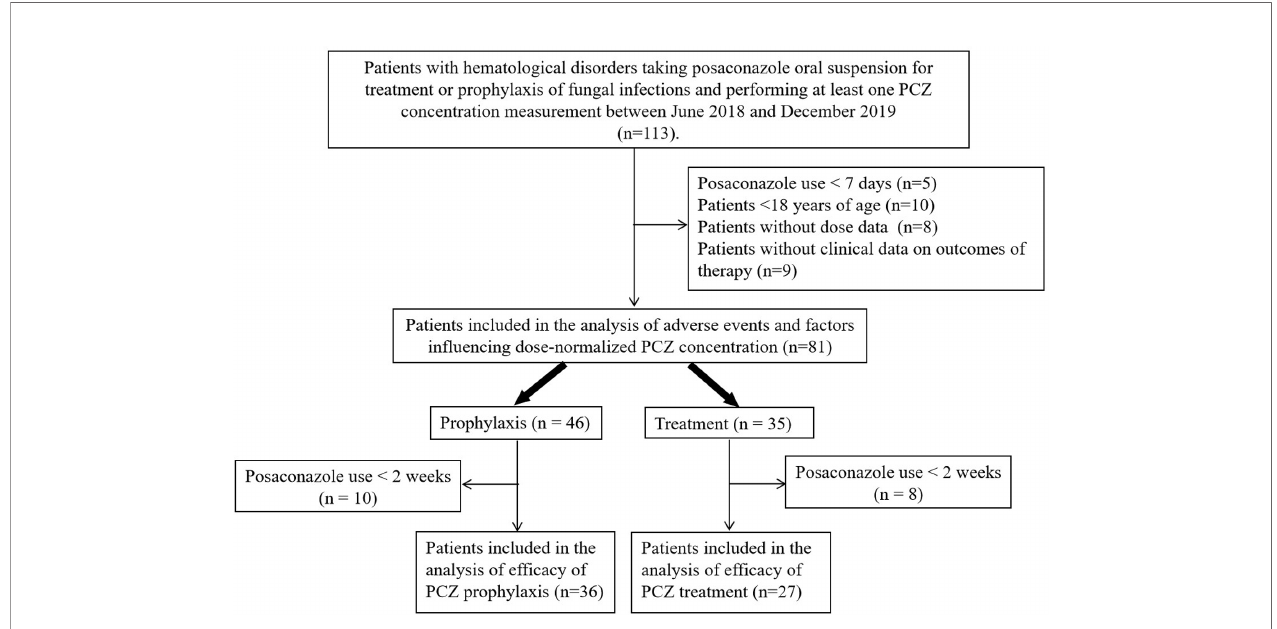
FIGURE 1 | Flow chart of the study.